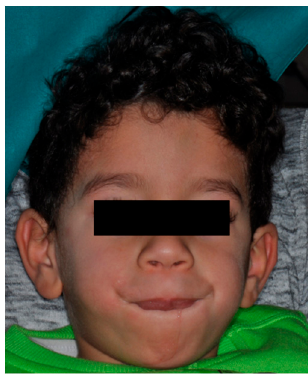
Figure 1. Facial phenotype of the child with Zimmermann-Laband-1 syndrome.